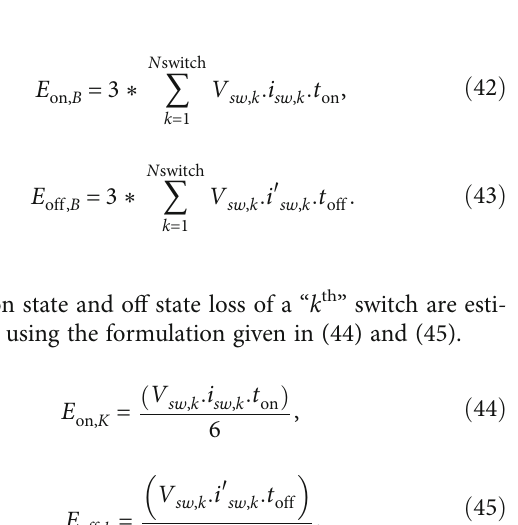
Figure 8: (a) Voltage across H-bridge switches S BMLDCLC. (d) Load current 3-phase BMLDCLC — RL load. (e) Load current 3-phase BMLDCLC — motor drive. (f) Blocking voltage of DC-link